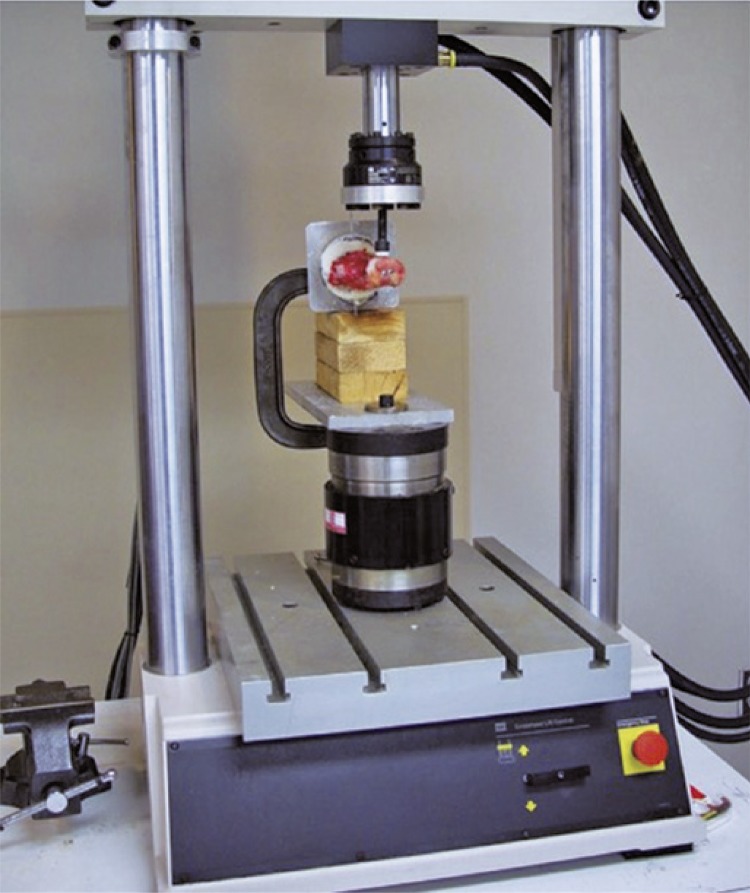
Configuração experimental. O construto foi fixado no sistema de testagem de materiais